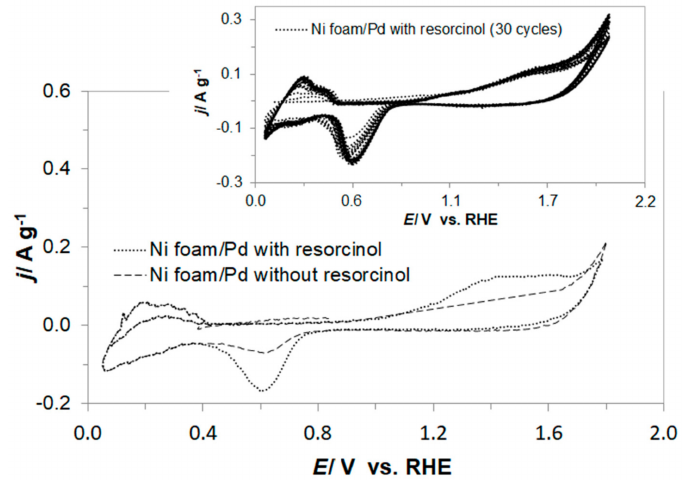
Figure 5. Cyclic voltammograms recorded on Pd-modified Ni foam electrode surface (inset presents 30 continuous CV sweeps) in 0.5 M Na 2 SO 4 supporting solution, carried out in the absence and presence of resorcinol (at 1 × 10 − 3 M), at a sweep-rate of 50 mV s − 1 .